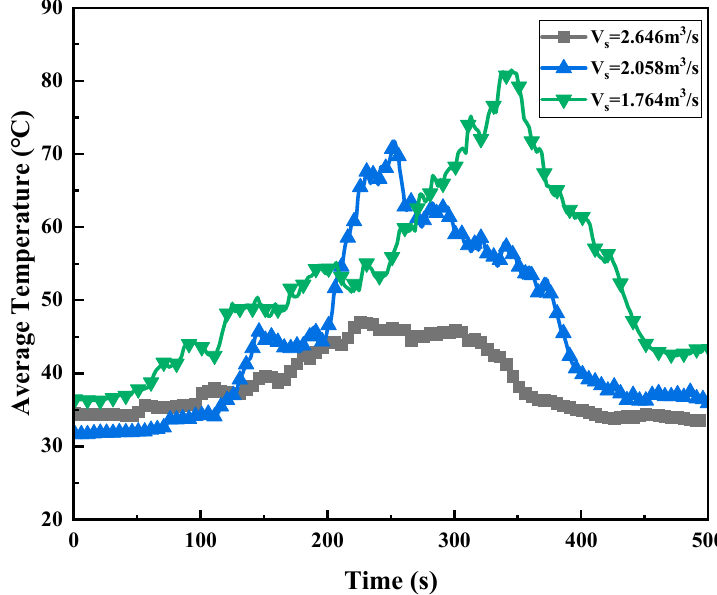
Figure 9. Temperature change at position 1 under different air supply volumes.